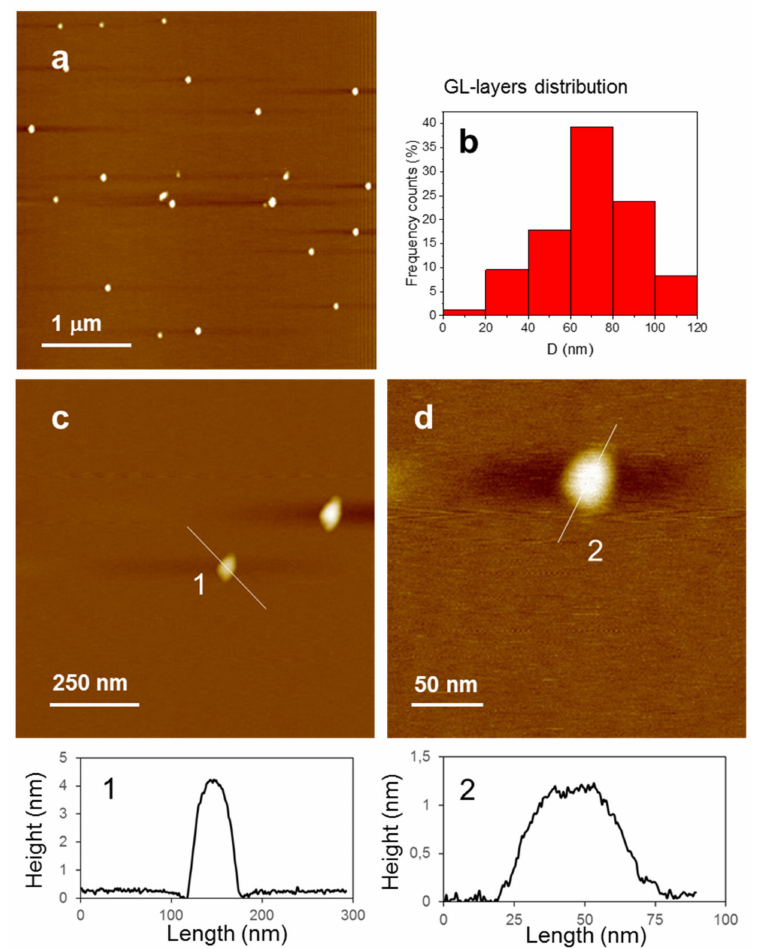
Figure 1. ( a – d ) NC-AFM topographic images of GL nanoparticles at di ff erent magnifications; ( b ) GL layers dimensional distribution; ( 1 – 2 ) height profiles taken along the lines highlighted in ( c , d )